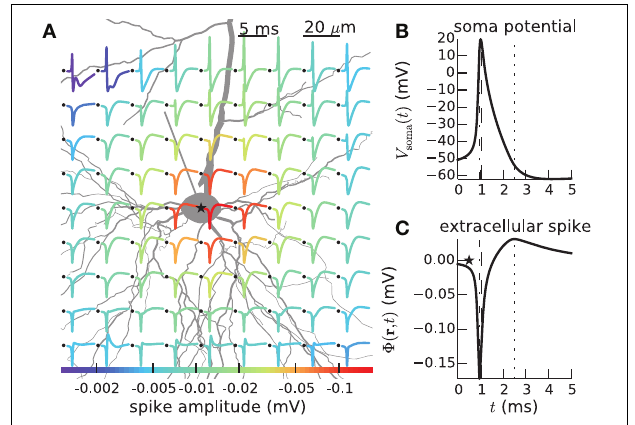
FIGURE 1 | Calculated extracellular spike waveforms using LFPy . (A) Position-dependent extracellular spike waveforms during an action potential in a rat L5b pyramidal-cell model (Hay et al., 2011) produced by executing example2.py , see section 4.2. Black dots correspond to the positions of the (virtual) electrode contact points. Spike traces at each position are normalized and color coded according to the magnitude of the negative peak. (B) Corresponding somatic membrane potential during the action potential. Vertical dashed lines illustrate temporal alignment with the maximum magnitude V soma ( t ) and of an extracellular waveform (C) for the position denoted with an asterisk in (A) . Corresponding alignment with the maximum positive extracellular peak is illustrated by vertical dotted